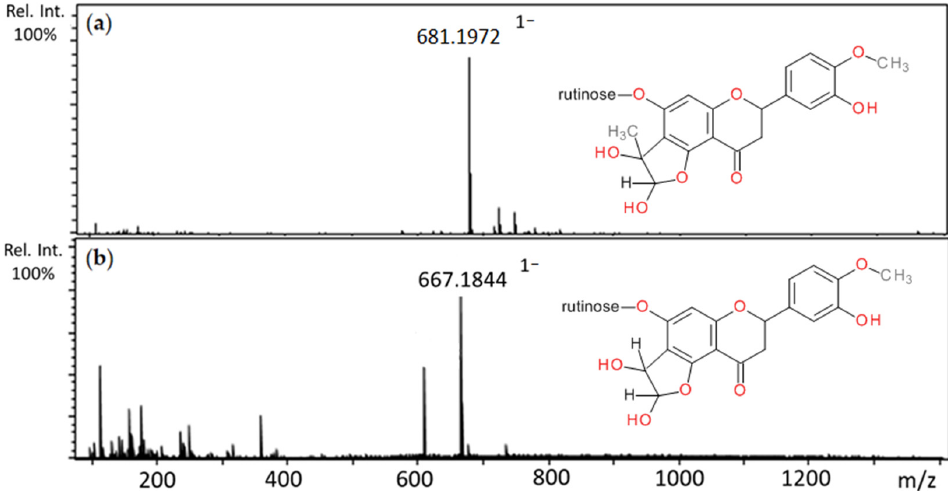
Figure 6. Mass spectra of methylglyoxal and glyoxal adducts with hesperidin after 1 h incubation in pH 7.4 phosphate buffer solution at 37 °C and their proposed chemical structure: ( a ) mono-MGO-hesperidin; ( b ) mono-GO-hesperidin; other isomeric forms are also